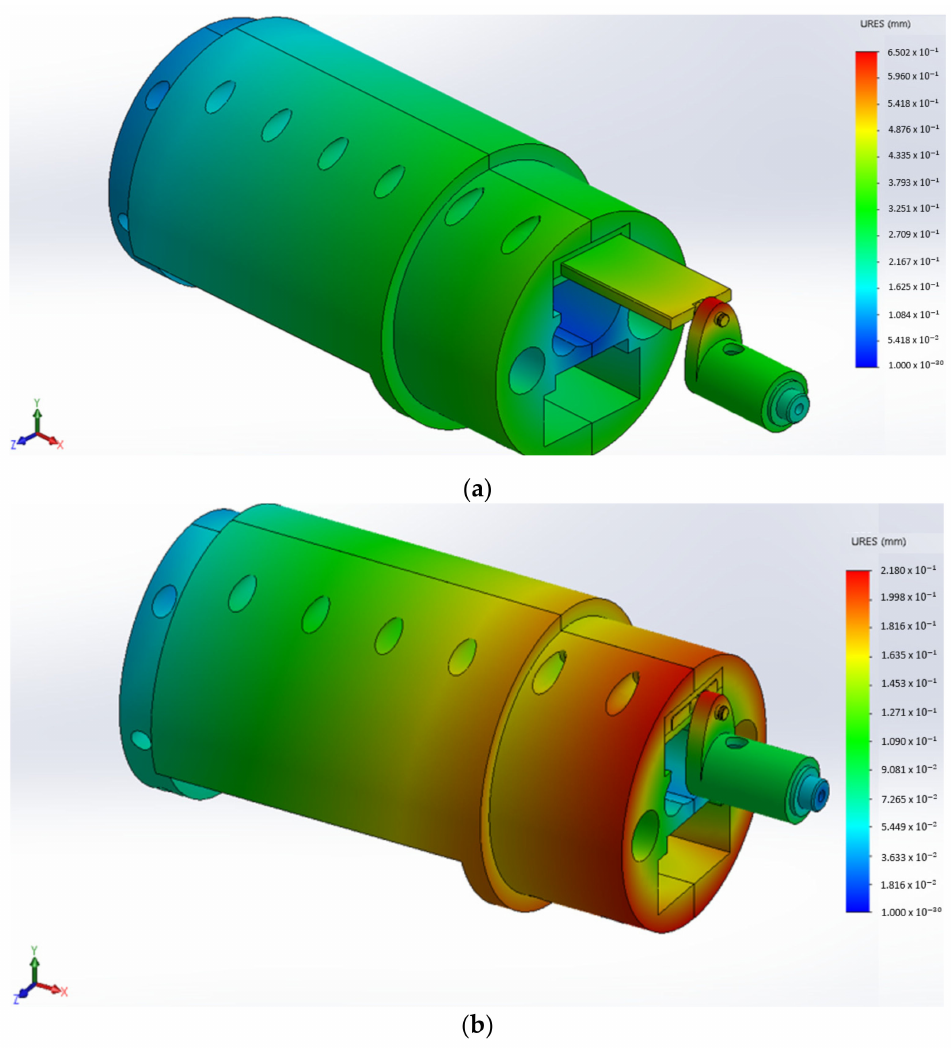
Figure 6. Total displacement when the rod is: ( a ) extended; ( b )